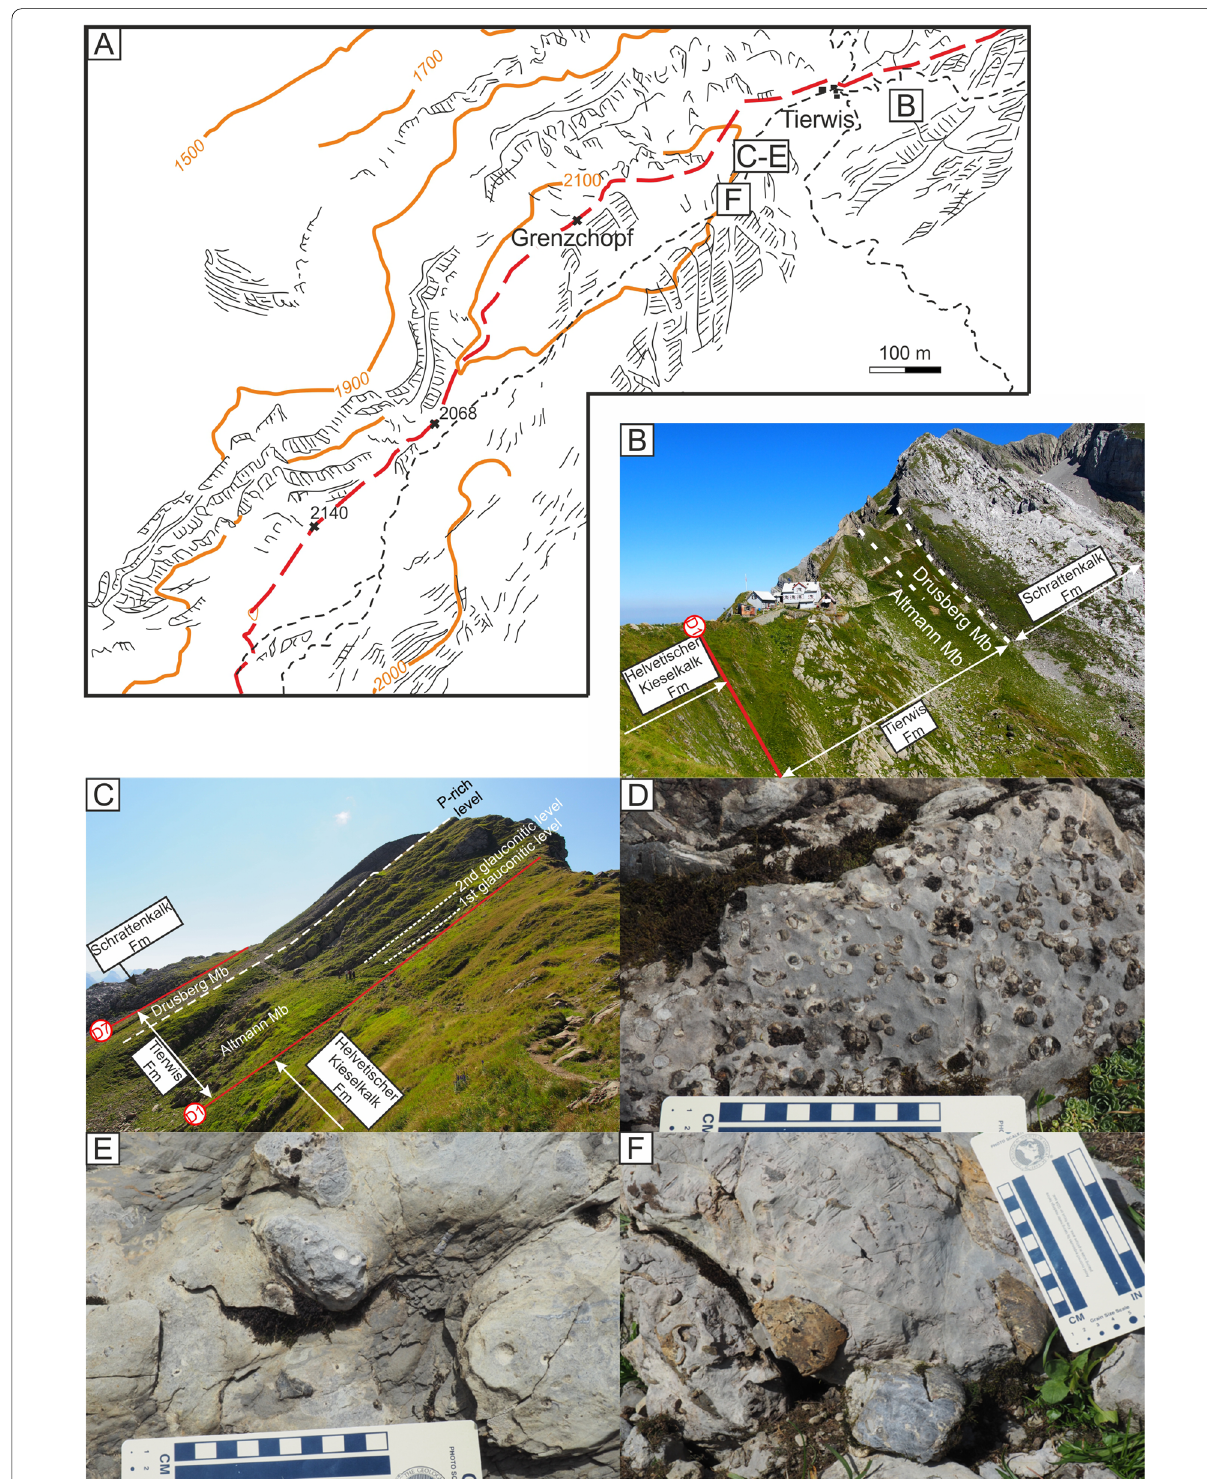
Fig. 4 (See legend on previous